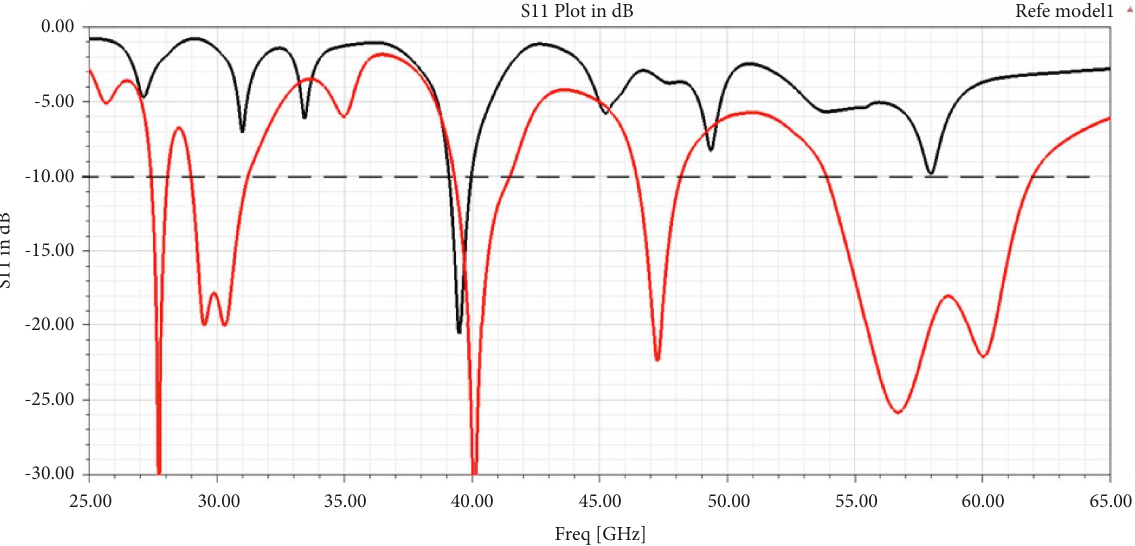
Figure 5: S curve for the genetically optimized antenna and the reference 11